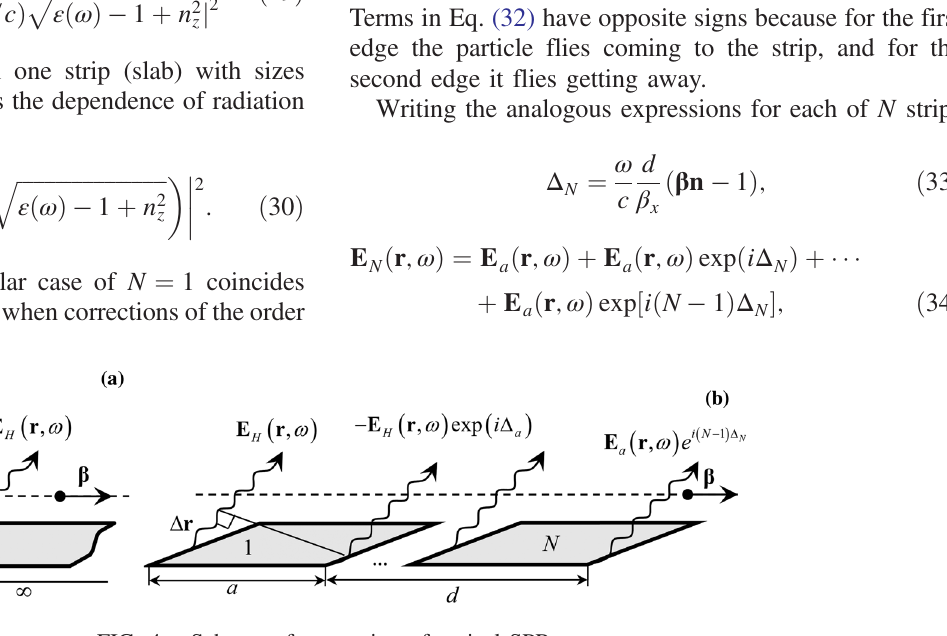
ffiffiffiffiffiffiffiffiffiffiffiffiffiffiffiffiffiffiffiffiffiffiffiffiffiffiffiffi p ε ð ω Þ − 1 þ n 2